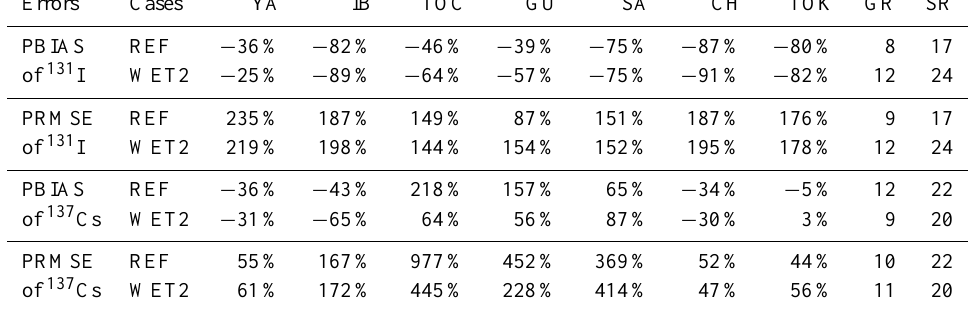
Table 7. The PBIAS and PRMSE of total daily depositions of 131 I and 137 Cs with different wet deposition schemes. GR represents the global ranks for PBIAS or PRMSE, and SR represents for the sum of the global ranks. The definition of GR and SR is shown in Sect. 3.1.2. “YA”, “IB”, “TOC”, “GU”, “SA”, “CH” and “TOK” represent the stations “YAMAGATA”, ‘IBARAKI’, “TOCHIGI”, “GUNMA”, “SAITAMA”, “CHIBA” and “TOKYO”, respectively.